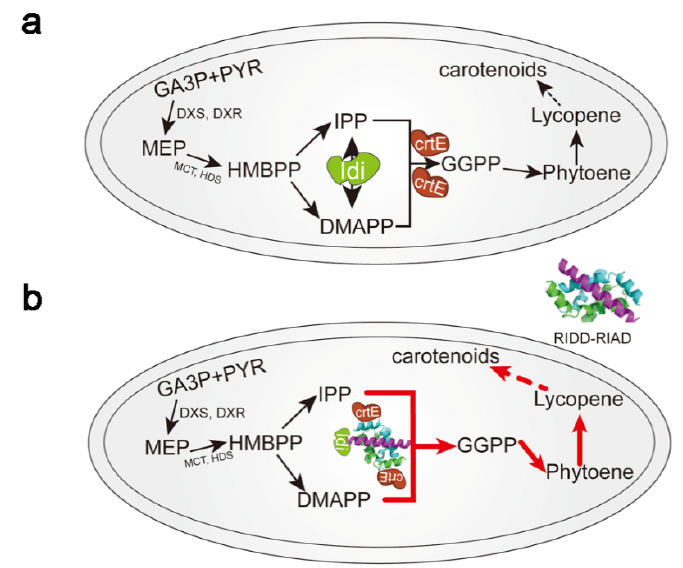
Figure 1. Schematic diagram showing Idi–CrtE (isopentenyl diphosphate isomerase-Geranylgeranyl diphosphate synthase) enzyme assembly. ( a ) Pathway of carotenoid synthesis in bacterial cells. ( b ) Idi–CrtE enzyme assembly using the RIAD–RIDD peptide enhances carotenoid synthesis. For carotenoid synthesis, Idi and CrtE represent the limiting step between the upstream MEP pathway and the downstream carotenoid pathway. GA3P: D-glyceraldehyde 3-phosphate; PYR: pyruvate;